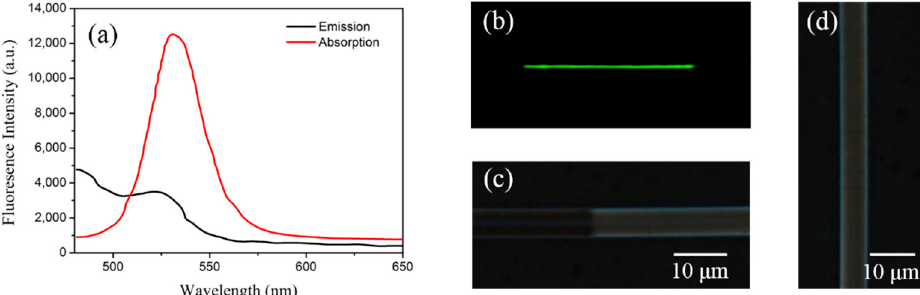
Figure 2. ( a ) The photoluminescence and emission spectra of the QD-UV glue; ( b ) the dark field image of the fabricated sensor under pump; the microscopy image of the fabricated sensor ( c ) with only the right half coated; ( d ) totally coated.